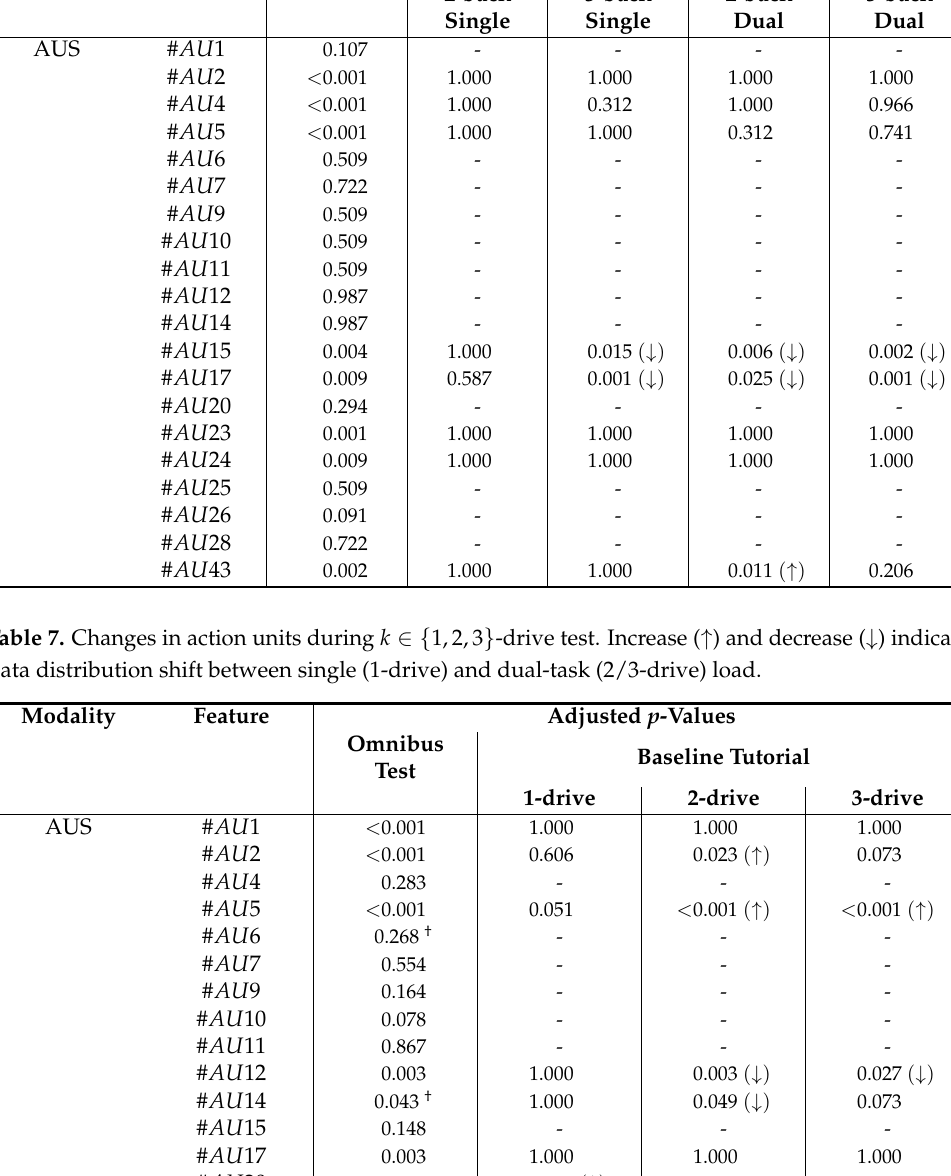
Table 6. Behavioral changes in FACS action unit for 2/3-back tests for a single and dual-task load. Every action unit occurrence is counted over every frame within a given window.